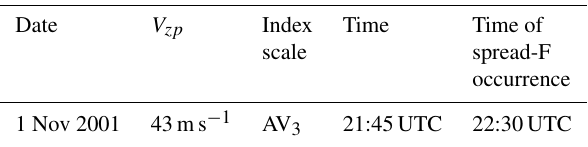
Table 2. Example of the relationship between the irregularity oc- currence and the V zp